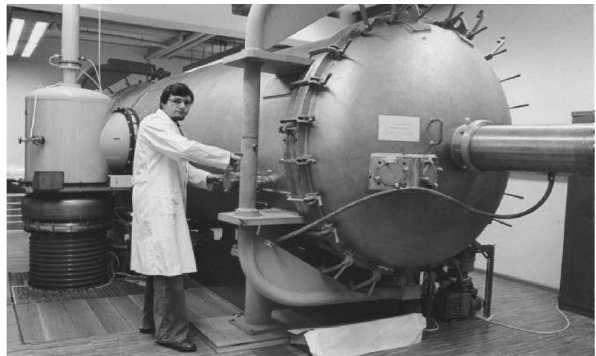
Figure 29: Laboratory equipment for simulating auroral and airglow processes (Strauss, Figure 29. Laboratory equipment for simulating auroral and air- 1980). glow processes (Strauss,